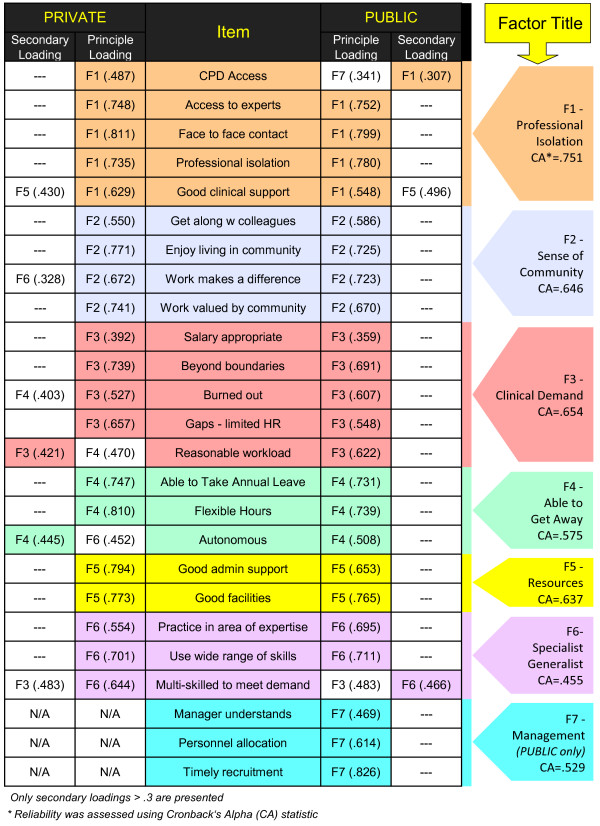
RAHW survey item loadings on factor analysis.